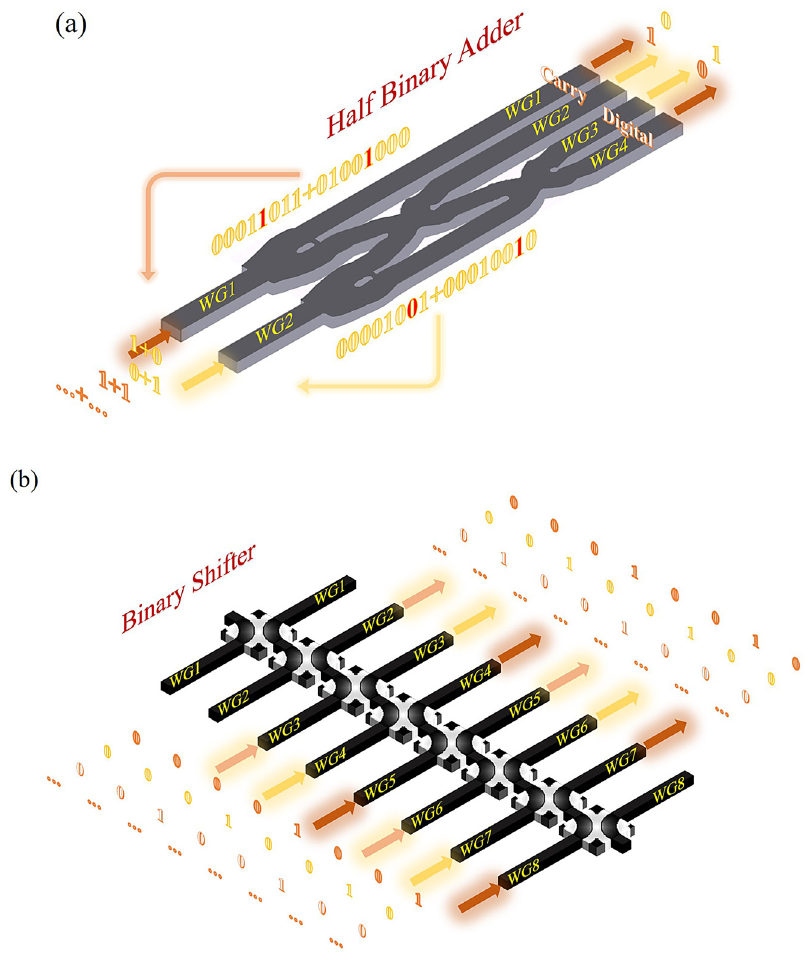
Figure 2: General configuration of the all-optical calculation part. (a) Configuration of the all-optical half binary adder. (b) Configuration of the all-optical binary shifter.